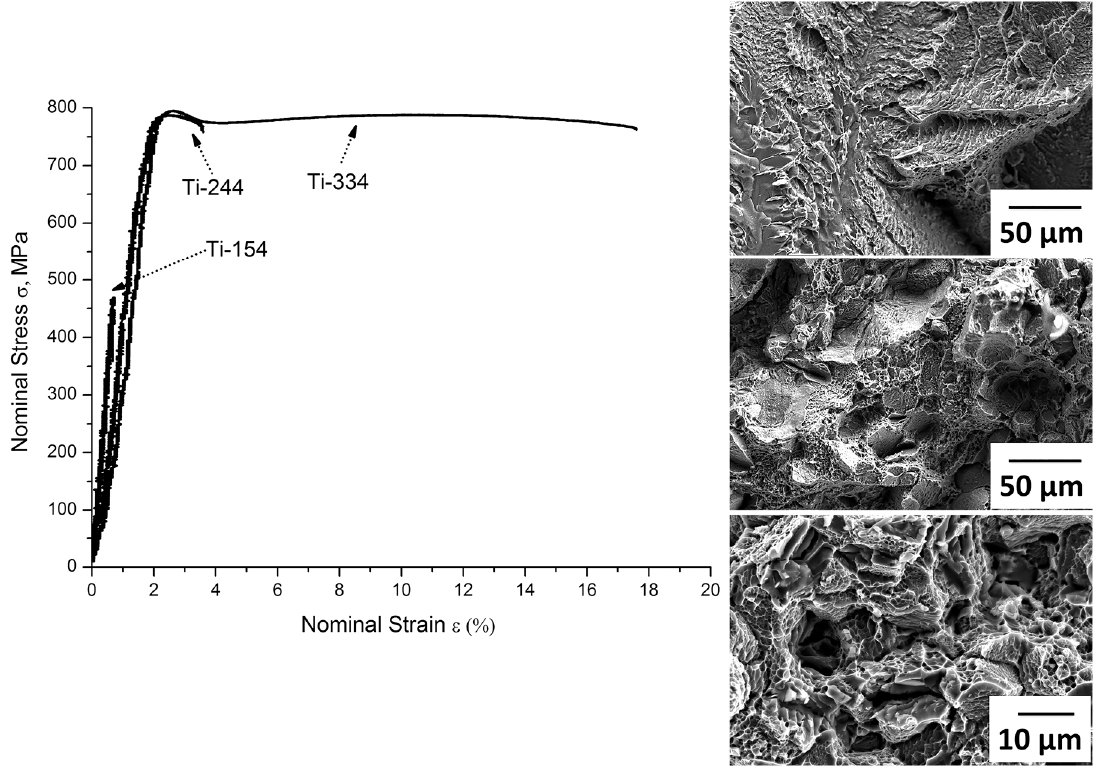
Figure 9. Representative engineering stress–strain curves and SEM micrographs of respective tensile fractographs of Ti-154, Ti-244 and Ti-334